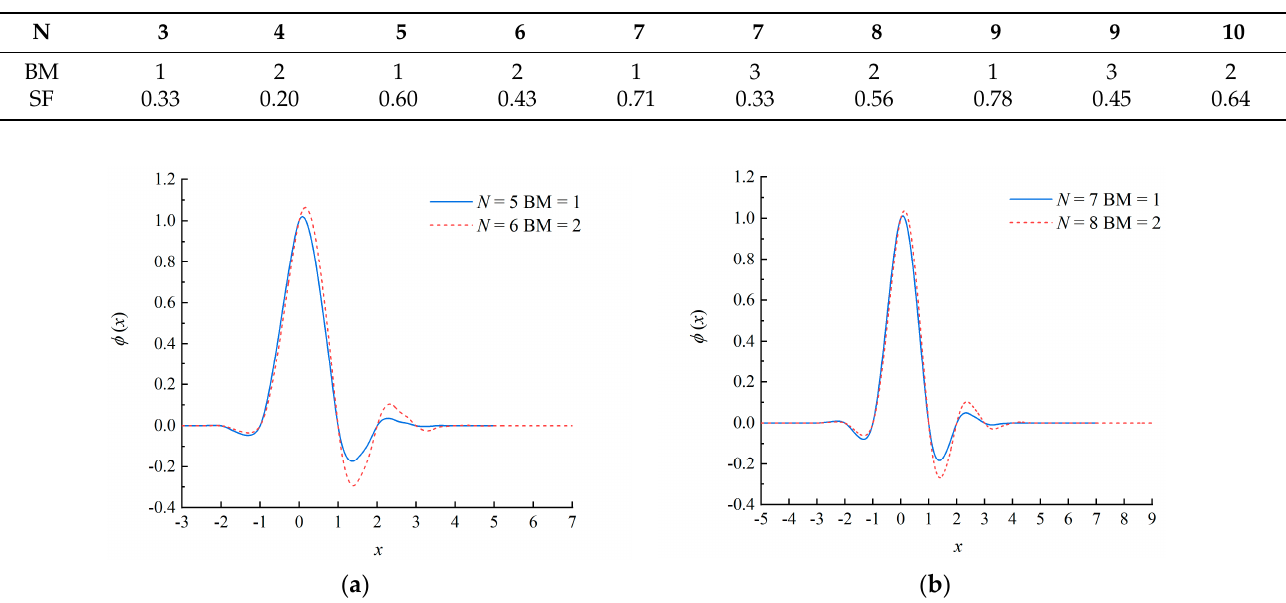
Table 1. BM and SF for the scaling functions.